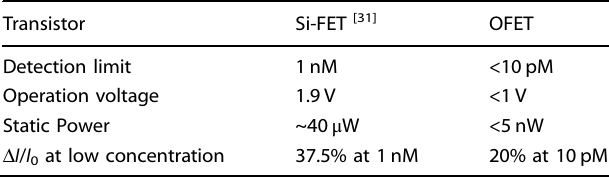
Table 1. Comparison of the performance of the OFET biosensor for miRNA detection to the previous work based on a silicon FET 31